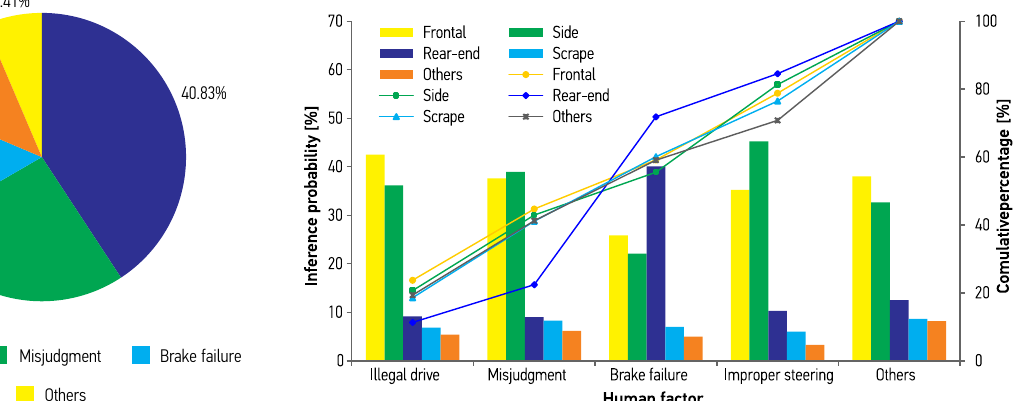
Fig. 6. Inference results of crash types (evidence: human